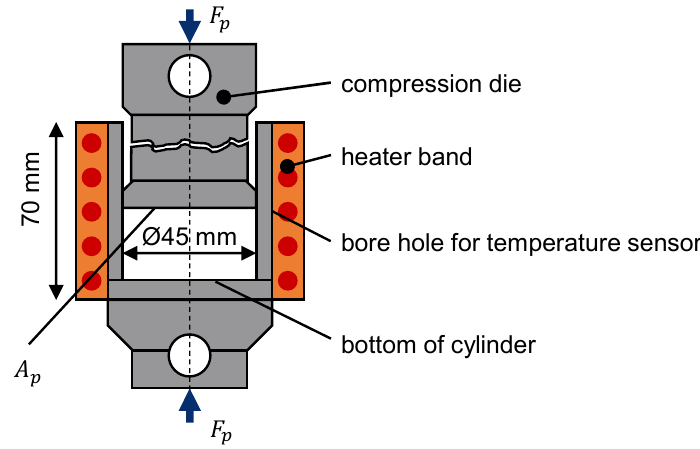
Figure 12. Compression test with a tensile/compression testing machine.